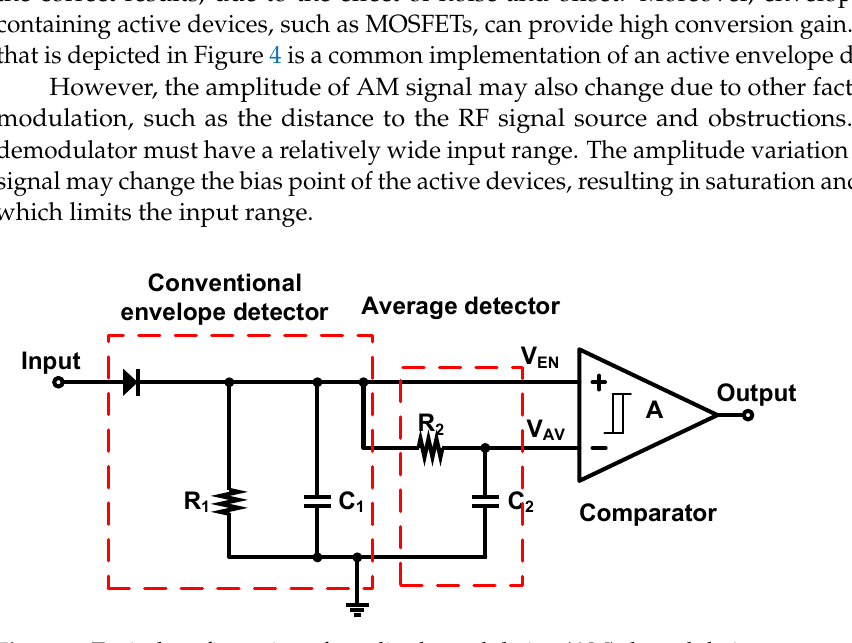
Figure 3. Typical configuration of amplitude modulation (AM)